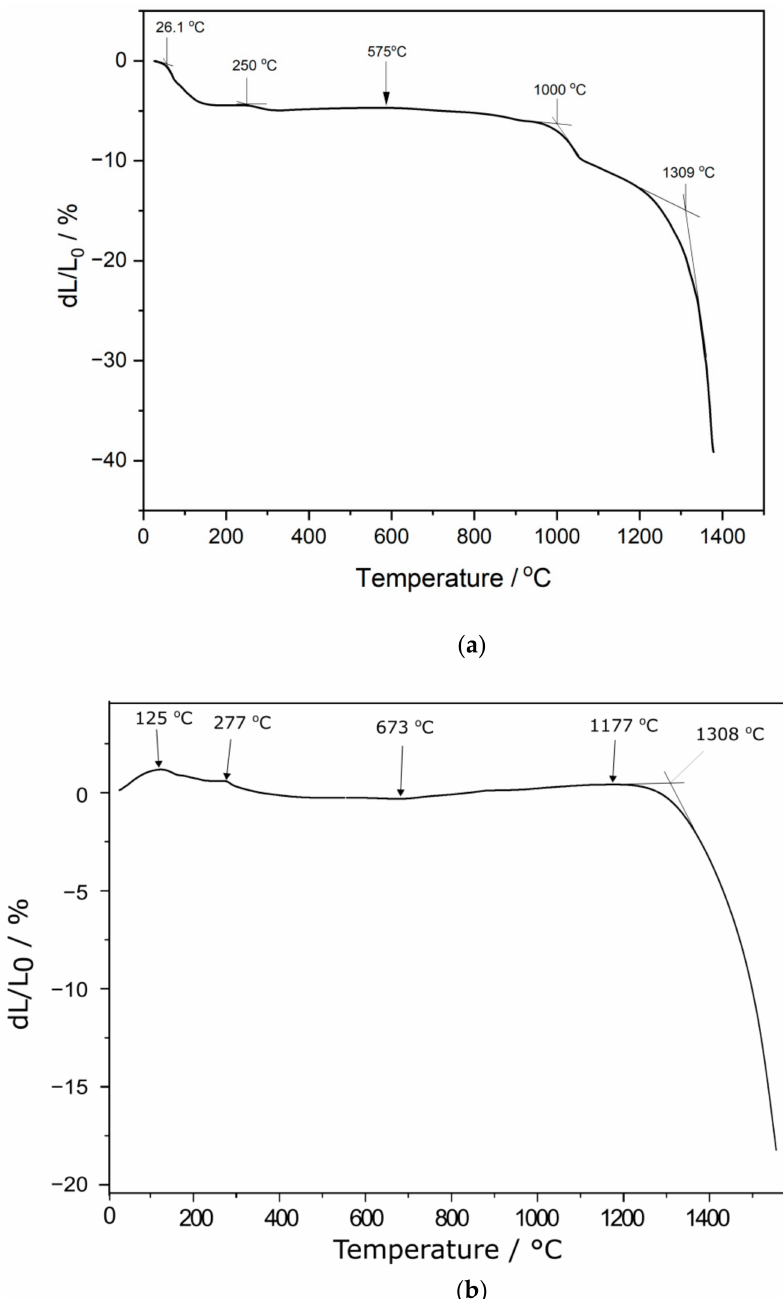
Figure 6. Dilatometric curve recorded for the NiO–5CBCY sample: ( a ) in air; ( b ) in